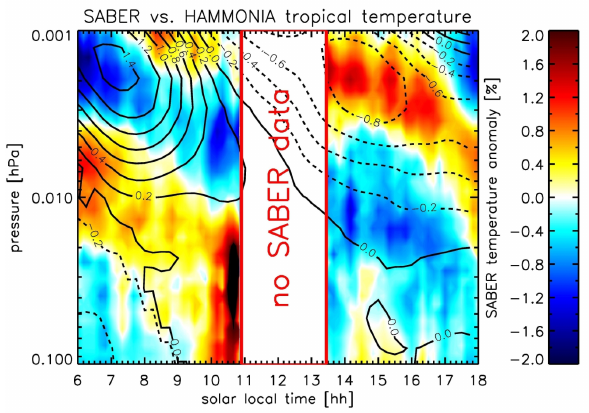
Fig. 6. SABER (color coding) and HAMMONIA (contour lines) daytime temperature variations (deviation from the daytime mean in %) between 0.1 and